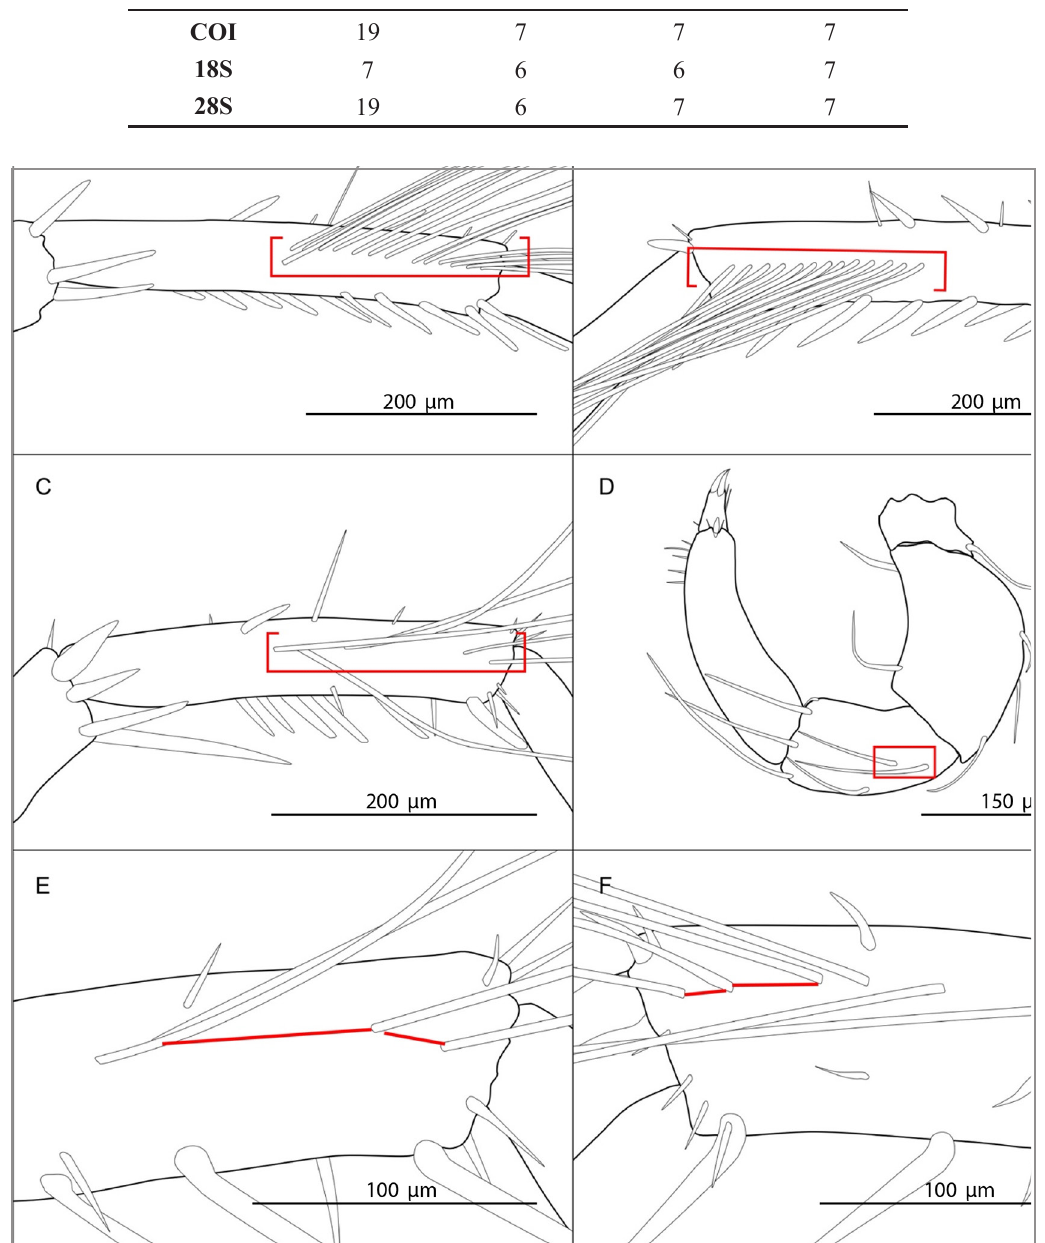
Fig. 6. Lebertia ( Pilolebertia ) spp. Examples of observed differences in setation. A–B . High number of setae on segment five of legs three and four (III-L-5, IV-L-5) present in Lebertia aggr. spp. B and D. C . Gap in swimming setae on the fifth segment of the second leg (II-L-5) in Lebertia aggr. spp. A and B, and L. obscura Thor, 1900. D . Segment three of palp (P-3) with a double proximal long seta sometimes present in Lebertia aggr. spp. D. E–F . Segment five of the second leg (II-L-5), close-up: comparison of swimming setae with and without the large gap